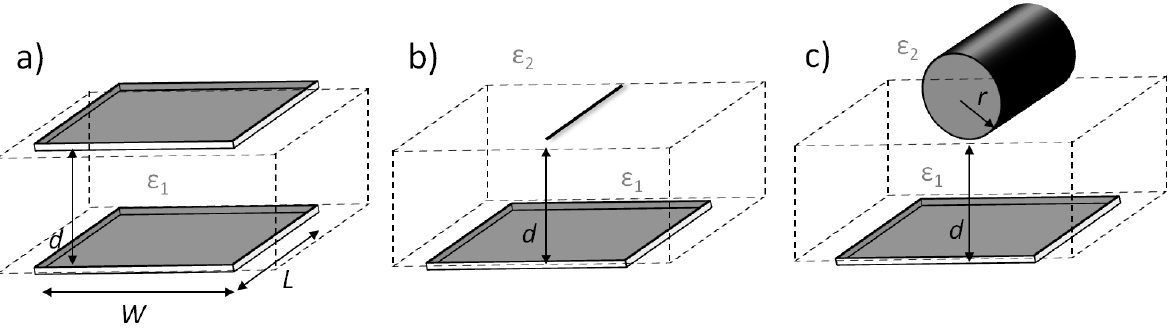
Figure 7. Capacitive models in use in fiber Field Effect Transistor (FET) mobility extraction procedures: ( a ) parallel plates capacitor; ( b ) wire-on-a-plane ( r << d ) capacitor and ( c ) cylinder-on-a-plane